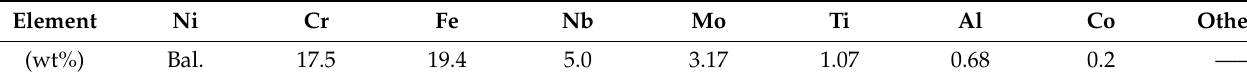
Table 1. Nominal chemical composition of Inconel ® 718 Ni-based superalloy.